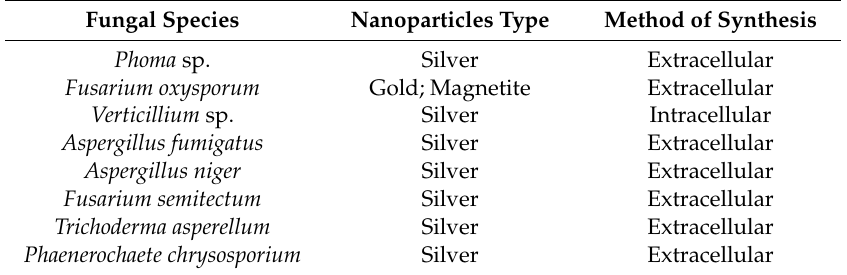
Table 3. Some examples of metallic nanoparticles produced by fungi and their method of synthesis [10,120]. Fungal